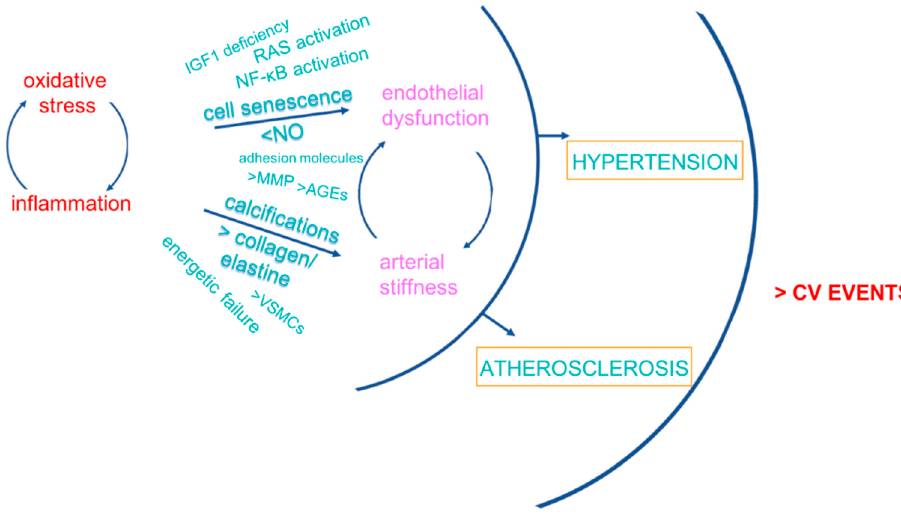
Figure 2. Functional and anatomical CV consequences of inflamm-aging/immunosenescence. AGEs: advanced glycation end products; IGF1: insulin-like growth factor 1; MMP: matrix metalloproteinases; NF- κ B: nuclear factor kappa-light-chain-enhancer of activated B cells; NO: nitric oxide; RAS: renin-angiotensin system; VSMCs: vascular smooth muscle cells